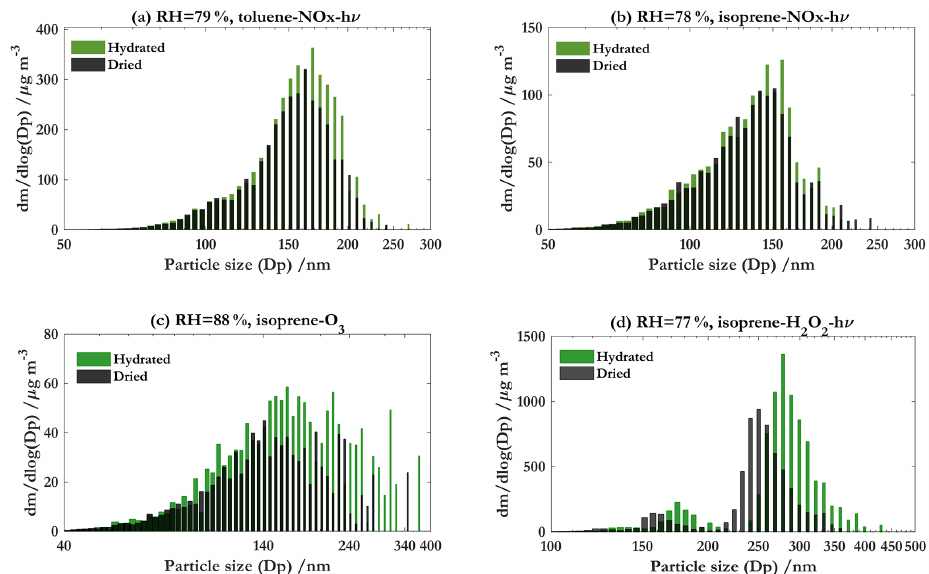
Figure 1. Mass concentration distributions of both dried and hydrated particles from both toluene and isoprene systems at 3h after the initiation of reaction.